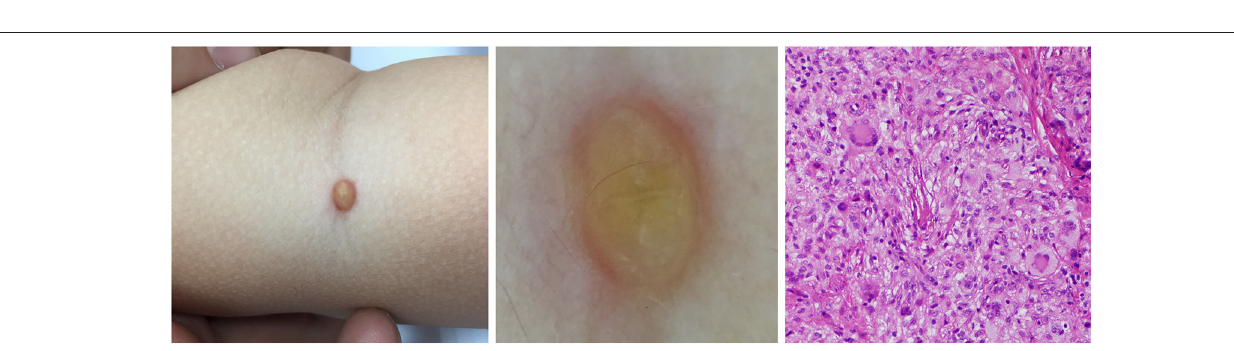
Frontiers in Medicine |